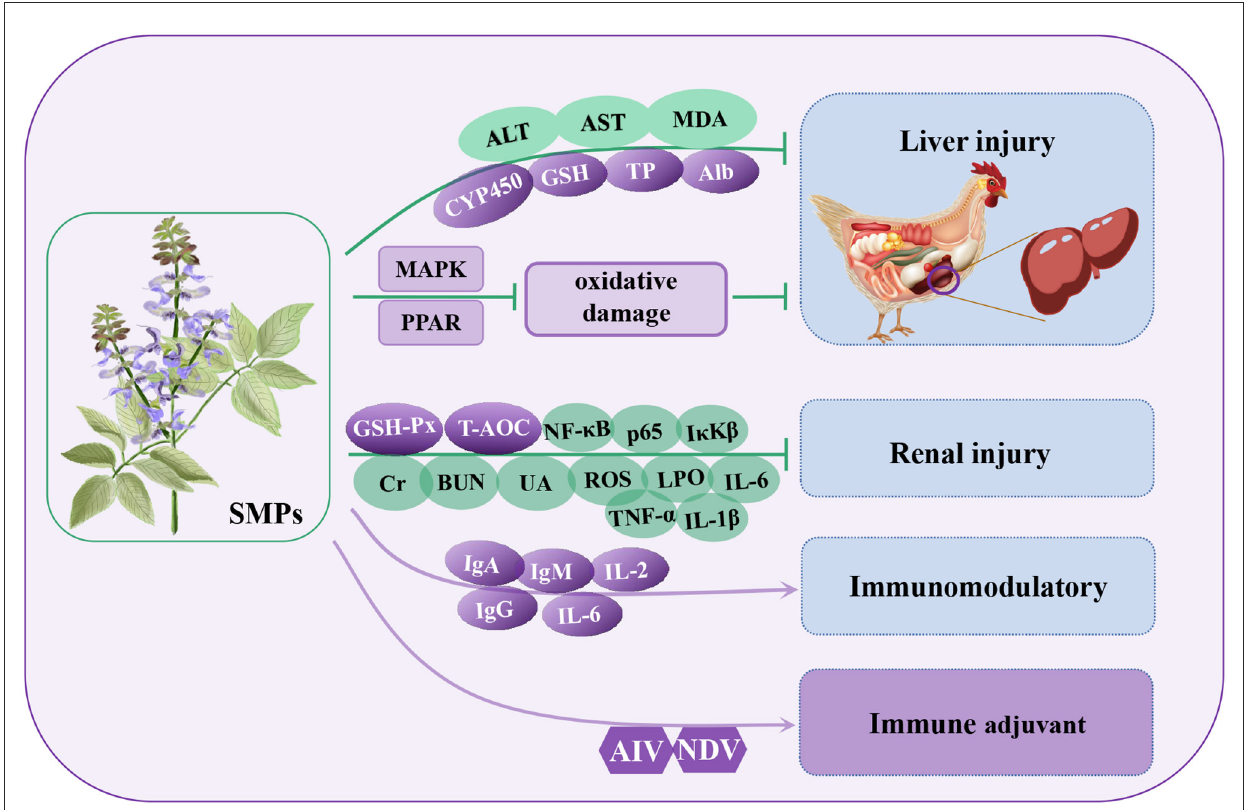
FIGURE6 Regulatory mechanisms of Salvia miltiorrhiza polysaccharides (SMPs) in organ protection in poultry. ALT, glutamic pyruvic transaminase; AST, glutamic oxaloacetic transaminase; CYP450, cytochrome P450; TP, total protein; Alb, albumin; MAPK, mitogen activated kinase-like protein; PPAR, peroxisome proliferator activated receptor alpha; BUN, blood urea nitrogen; Cr, creatinine; UA, uric acid; LPO, lipid peroxide; I κ K β , inhibitor kappa B kinase β .